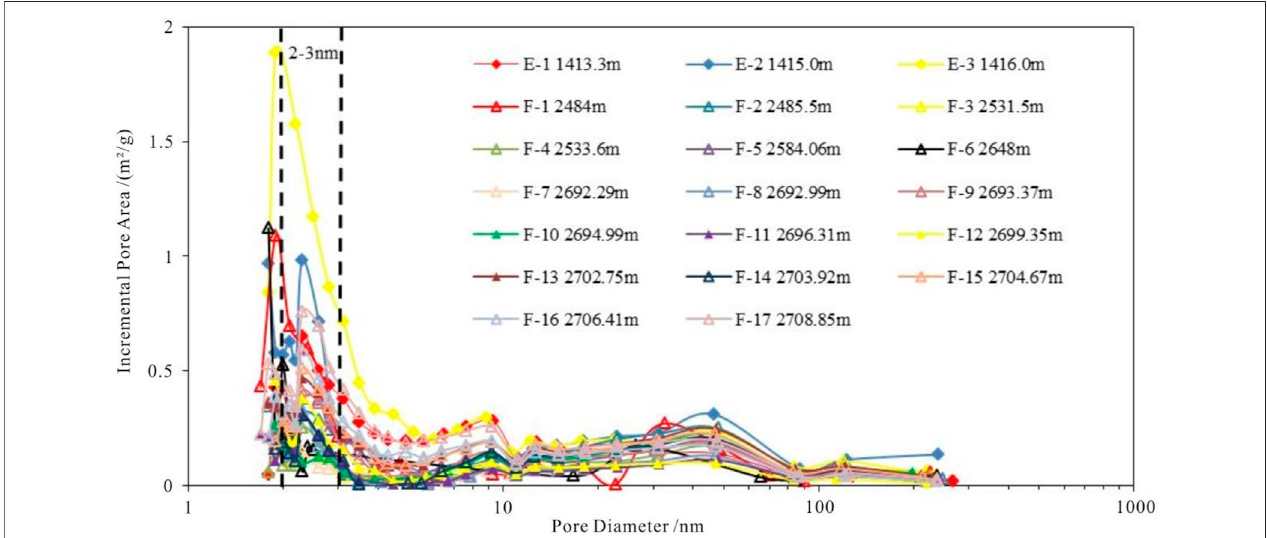
FIGURE 12 | Comparison of the pore diameter and incremental pore are of Shanxi Formation shale samples.